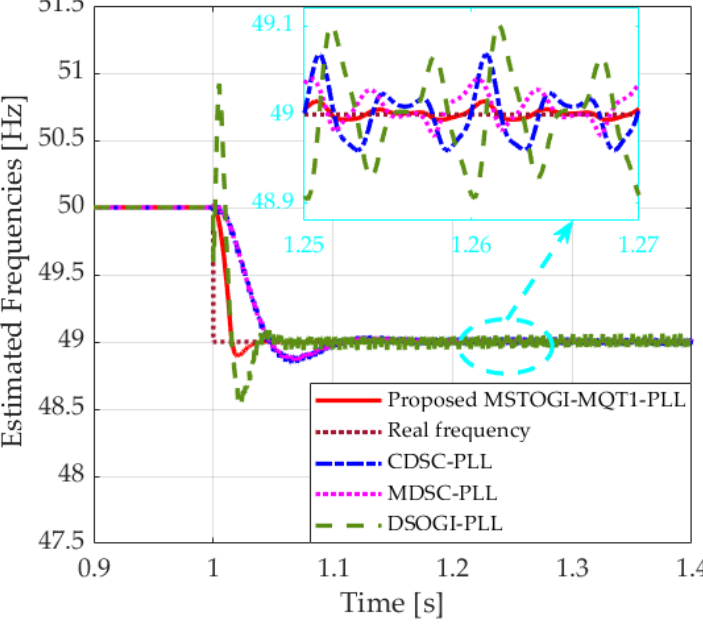
Figure 17. Estimated frequency for all studied methods for scenario 2.